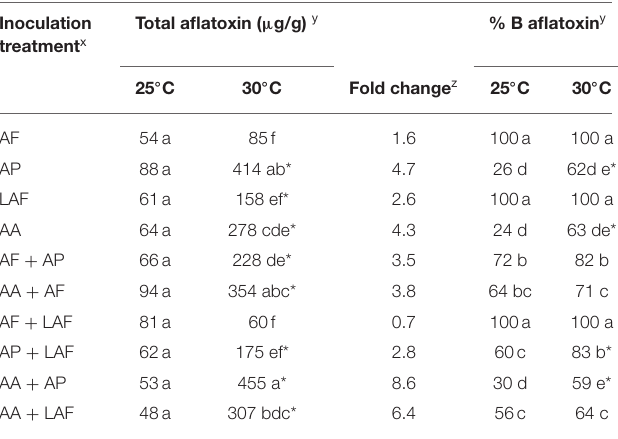
TABLE 2 | Effect of temperature and co-inoculation of Aspergillus isolates on aflatoxin production on maize kernels at 25 and 30 ◦ C. Inoculation treatment